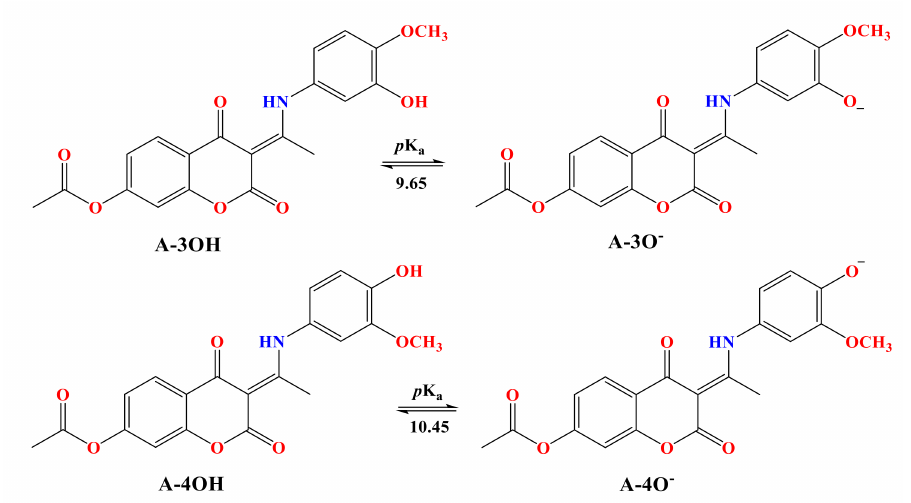
Figure 2. Possible deprotonation pathways and estimated p Ka values of the investigated